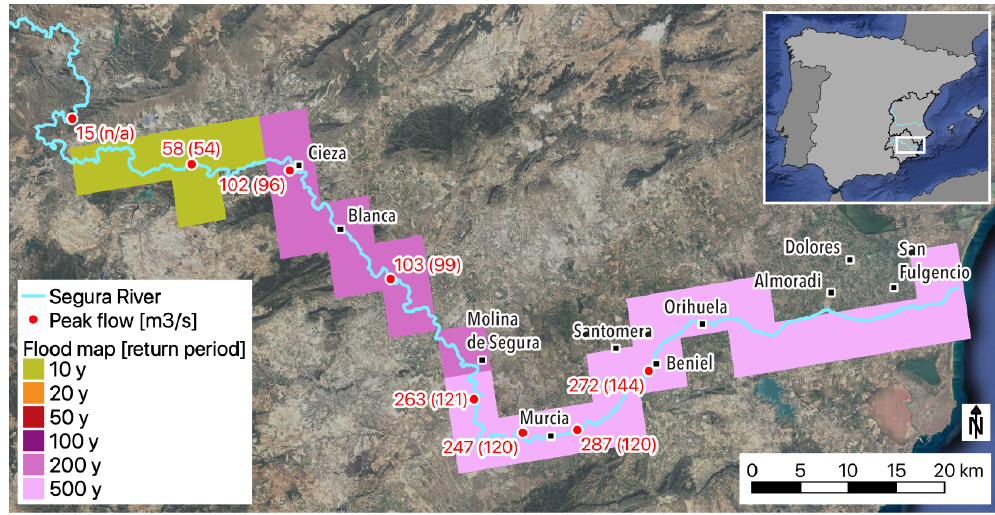
Figure 2. Peak flows measured at gauging stations in the Segura River during the DANA event, and (in brackets) at each station the input discharge of the most closely corresponding EFAS flood map. The 5km grid cells represent the resulting selection of EFAS flood maps along the LISFLOOD drainage network. Map data © Google Earth